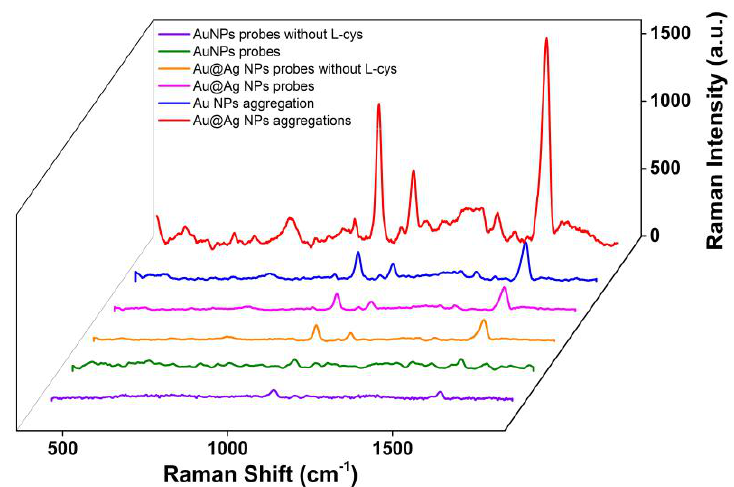
Figure 3. Raman spectra of Au NPs probes, Au NPs probes without L -cys, Au@Ag NPs probes, Au@Ag NPs probes without L -cys, Au NP aggregates, and Au@Ag NP